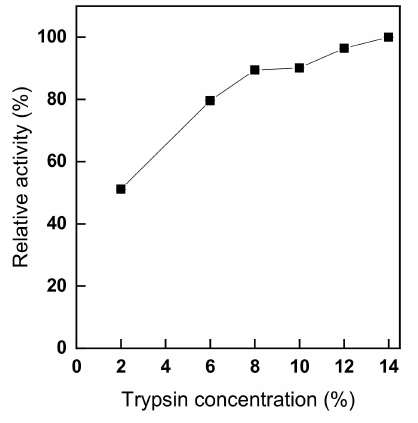
Figure 4. The e ff ect of trypsin concentration on the activity of trypsin immobilized onto glutaraldehyde-pre-activated chitosan nonwoven (trypsin immobilization: pH 8.5, 1 h, 25 ◦